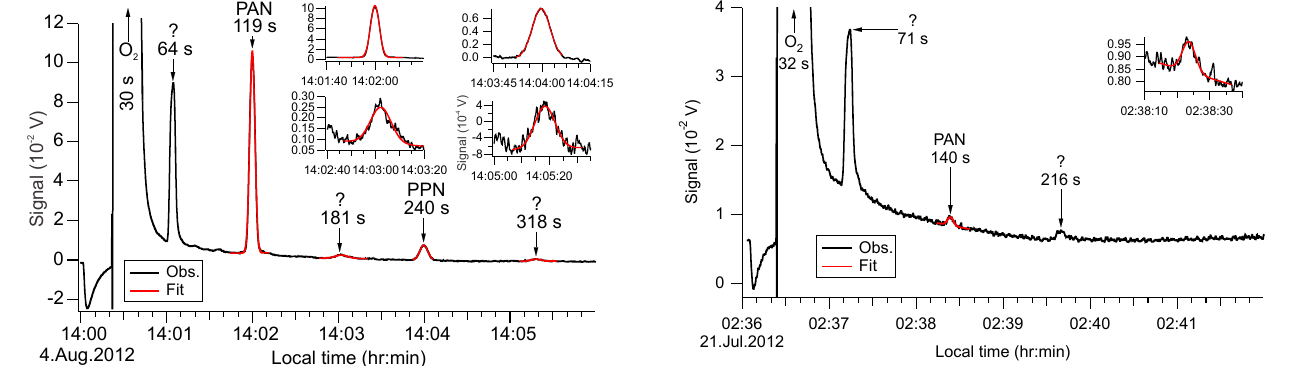
Figure 8. Chromatogram of ambient air acquired in Abbotsford on 4 August 2012, 14:00 local time. The red lines are fits of Eq. (1) to the observed peaks, which are also shown as inserts. The peak areas correspond to a PAN mixing ratio of 1.67ppbv and a PPN mixing ratio of 163pptv, which were the largest peak areas observed in Abbotsford. Table 7. Relative response factors of the PAN-GC for PAN, PPN, MPAN and APAN, and recent literature values. nd = not deter- mined; nr = determined, but not disclosed.